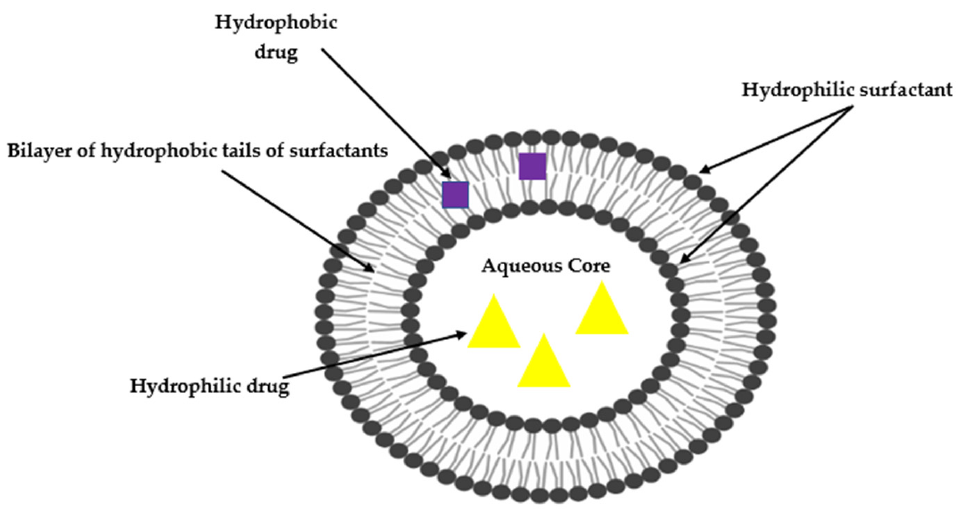
Figure 1. Schematic representation of a typical bilayered lipid vesicle.